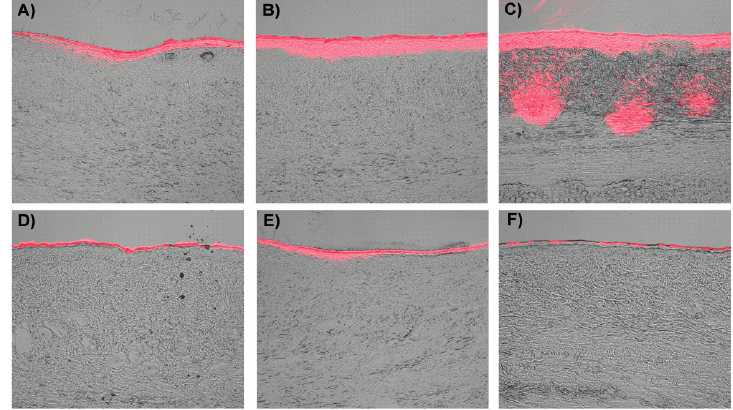
( A ) 1 h; ( B ) 6 h; ( C ) 24 h. PBS Gel labeled red fluorescence (Rhodamine) penetrated the scar tissues after ( D ) 1 h; ( E ) 6 h; ( F ) 24 h. (Original magnification of A – F is 20×).